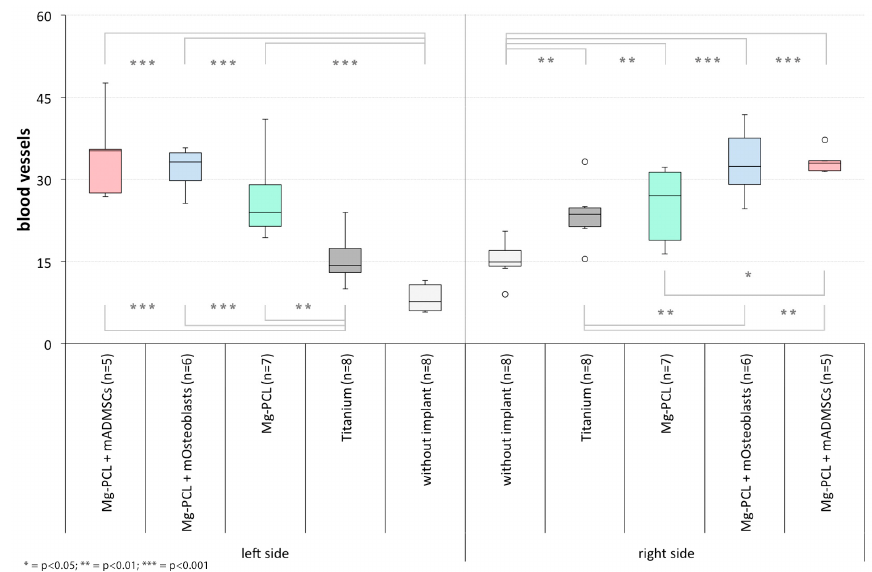
Figure 13. Counted intraosteal blood vessels on slides of mice treated without an implant, with uncoated titanium implants, non-previtalised Mg-PCL implants and Mg-PCL implants previtalised with either mOsteoblasts or mADMSCs for both skull halves(* = p < 0.05; ** = p < 0.01; *** = p < 0.001; whiskers = minimal and maximal values; horizontal line = median; circles = outliers).